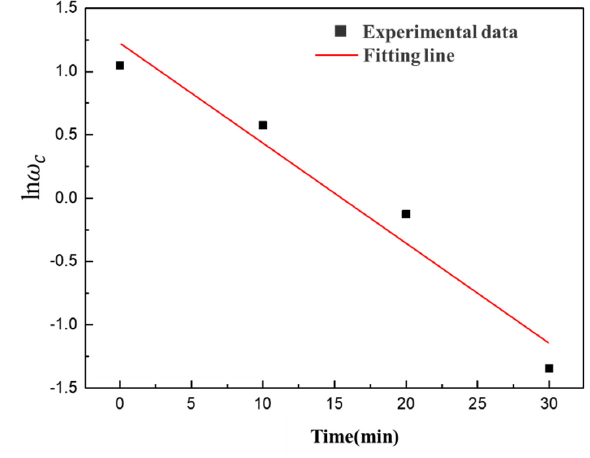
Figure 11. Fitting of mass transfer coefficients of decarburization for the second stage when blowing pure O 2 .